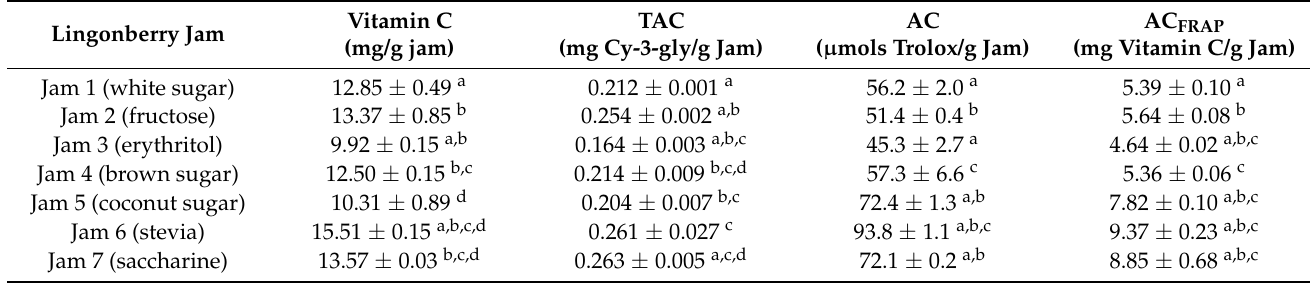
Table 1. Vitamin C content, TAC and AC of non-digested lingonberry